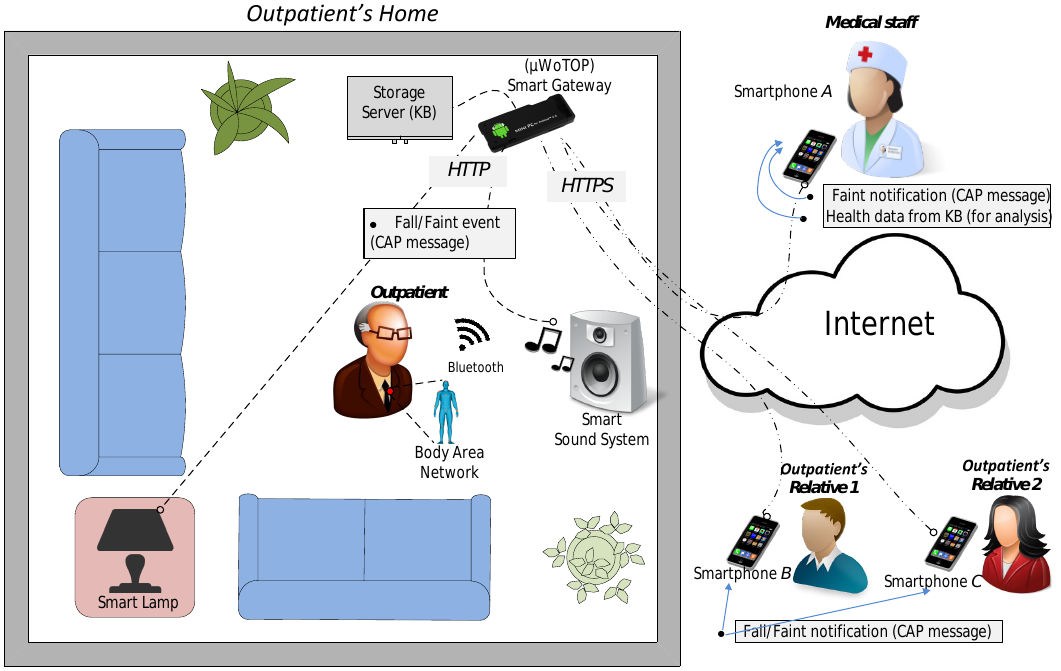
Figure 9. Motivation scenario: integral healthcare system for promoting independent living of the